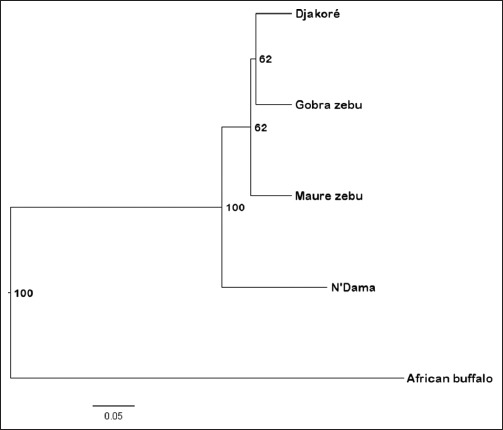
Phylogenetic tree constructed from DA [30] by the unweighted pair group method with arithmetic mean method showing genetic relationships among four Senegalese cattle breeds. Numbers represent the percentage of times that a node occurred in 10,000 bootstrap replicates. The linear scale relates the branch lengths to units of DA. The root of the tree was placed at the midpoint of the longest branch separating the African buffalo from the other groups.